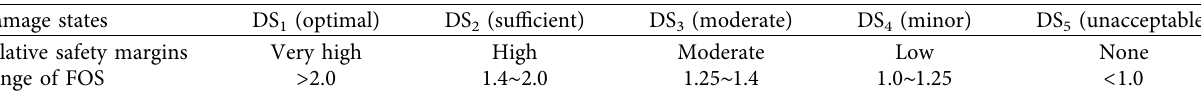
Table 3: Adopted damage states for open-pit mine slopes in terms of